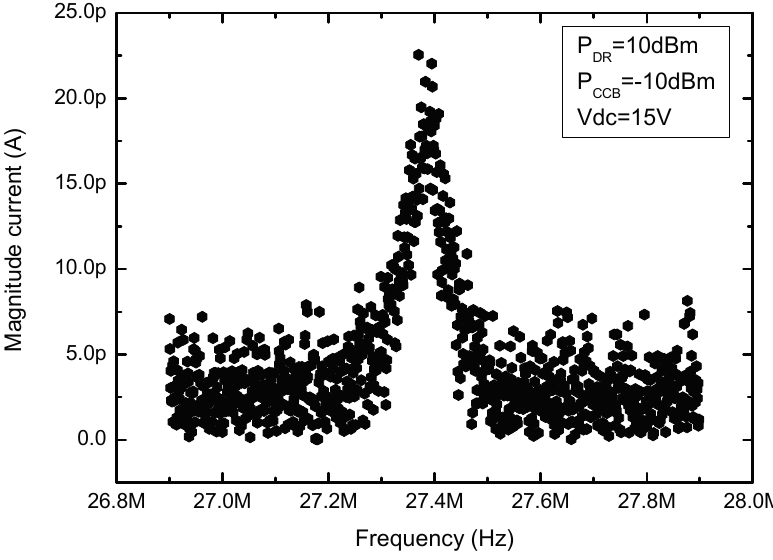
Figure 4. Frequency response obtained from the CMOS-NEMS clamped-clamped beam with the piezoresistive transduction method in